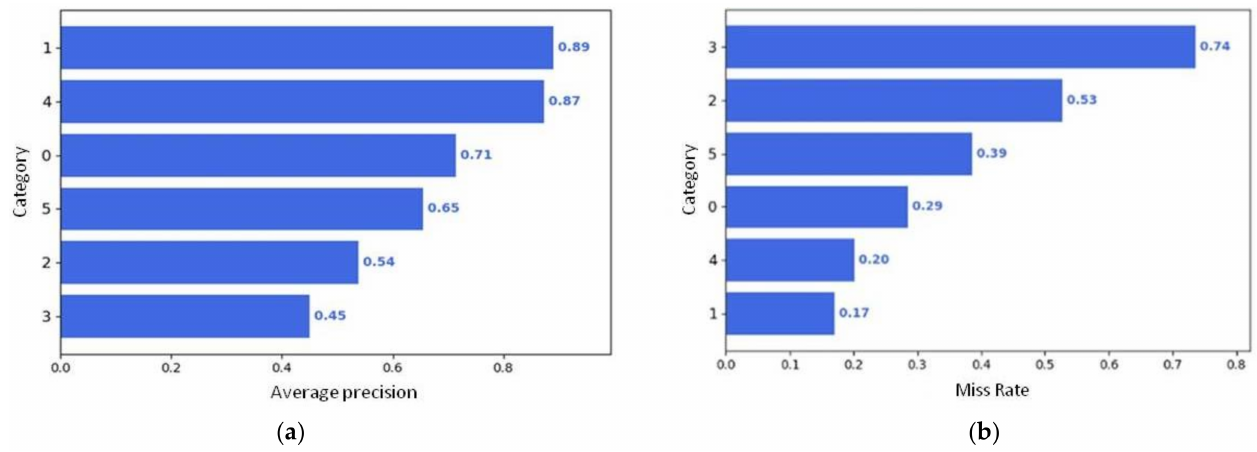
Figure 9. Average precision and miss rate for 6 pavement defect categories. ( a ) Average detection accuracy of each category; ( b ) Miss rate of each